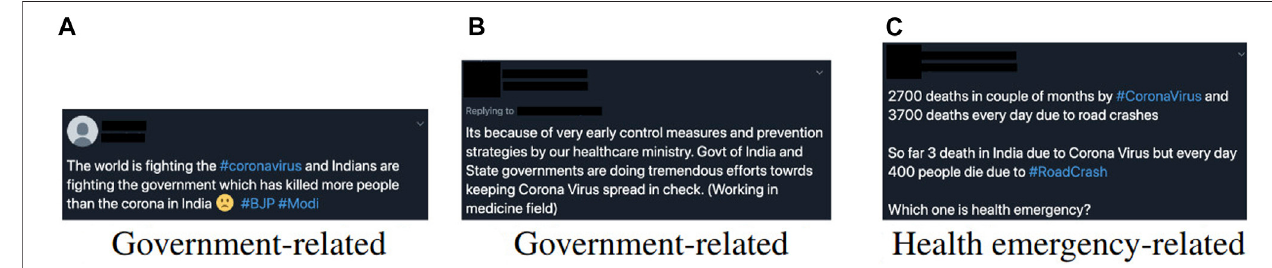
FIGURE 1 | Sample tweets belonging to the popular Empath categories.